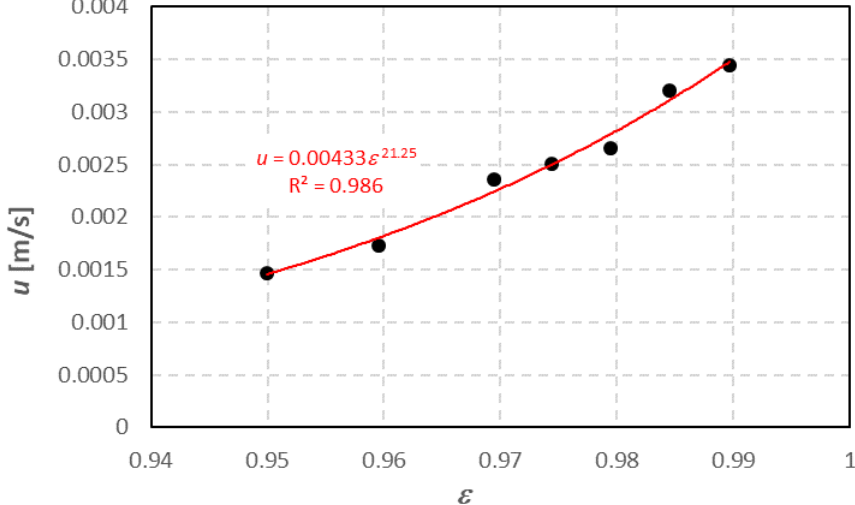
Figure 6. Evaluation of the dependence of the hindered settling velocity of the cloud of the fiber suspension on the porosity of the suspension cloud in glycerine, according to Equation (4).